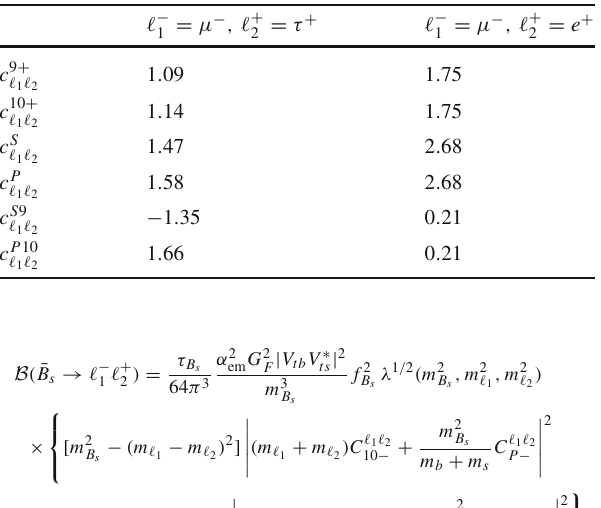
Table 4 Predictions for the coefficients describing B + → K + (cid:3) − decays using the hardonic form factors from Refs. [89,90]. We note that these coefficients are independent of the charges of the leptons, except for c S 9 (cid:3) which changes sign depending on the charge of the heavier 1 (cid:3) 2